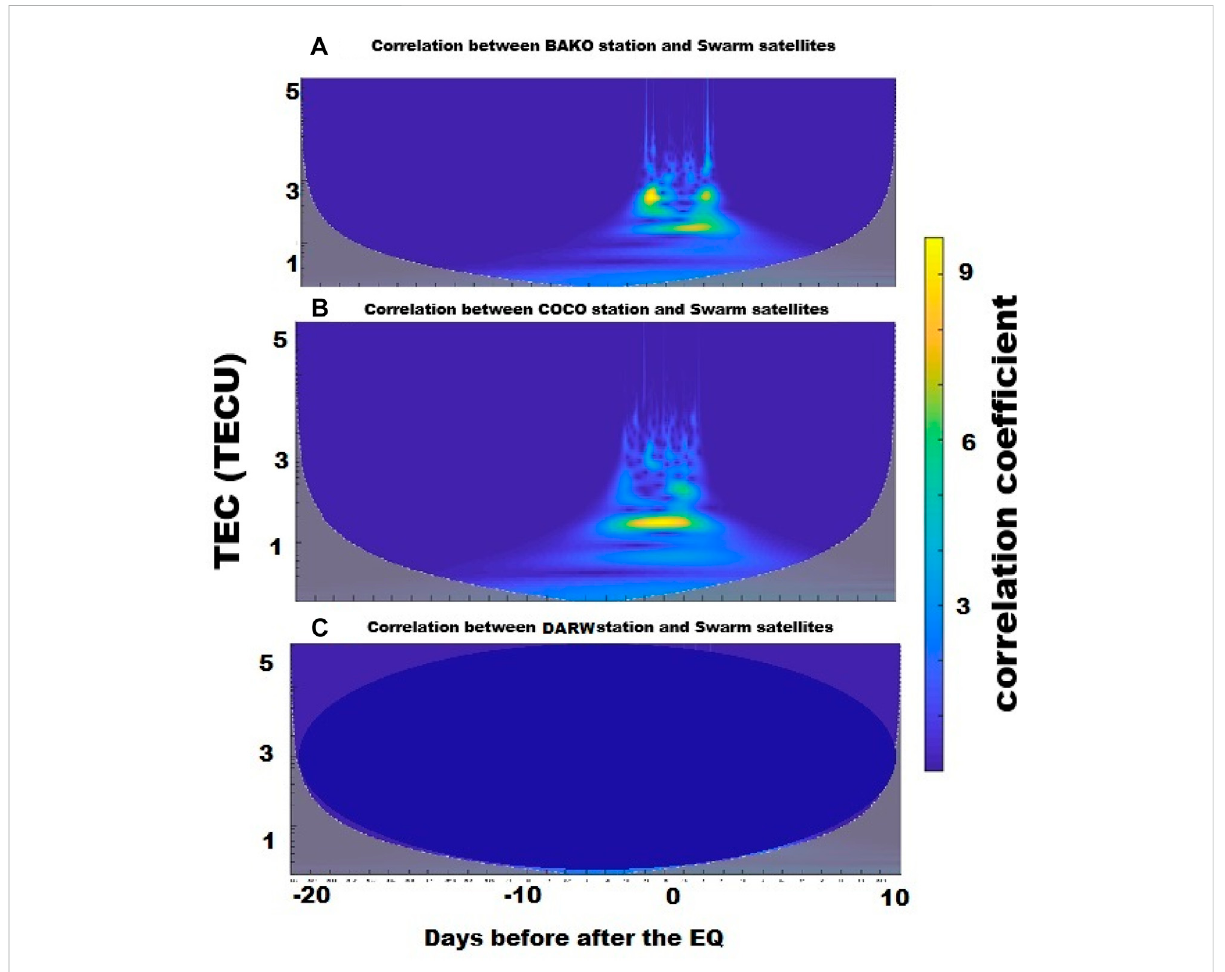
FIGURE 6 Wavelet correlation between the TEC from Swarm satellites and GPS stations associated with the Sumatra